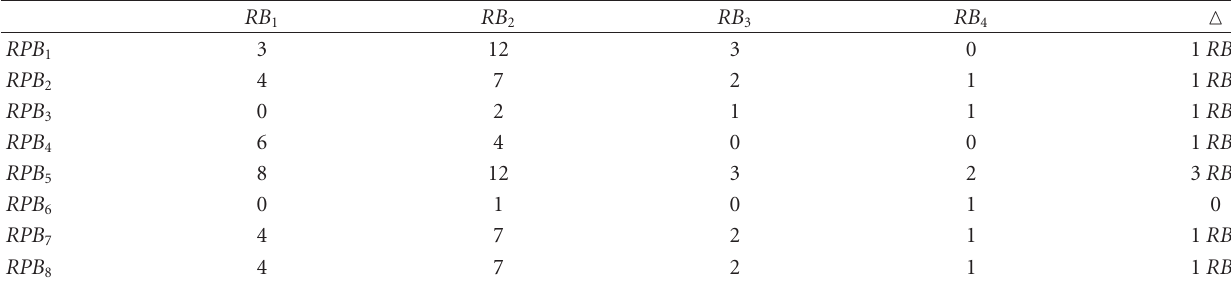
Table 5: Comparison of number of RBs between RZs and RPBs.